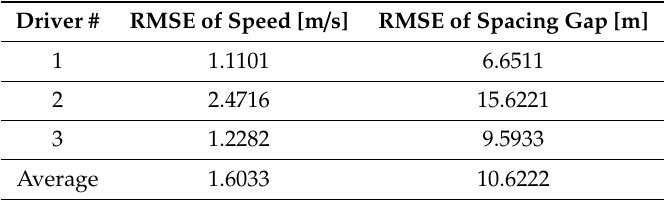
Table 3. Error of velocity and spacing gap by